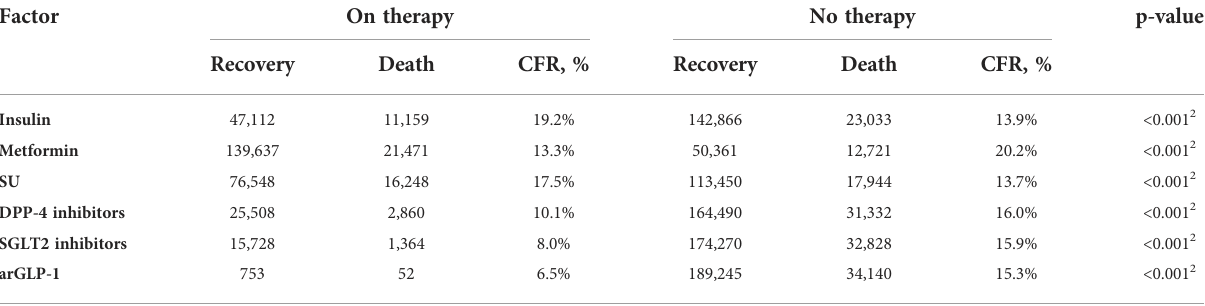
TABLE 3 Comparison of CFR in T2DM groups according to the kind of receiving pre-COVID-19 glucose-lowering therapy (yes/no) (n = 224,190). Factor